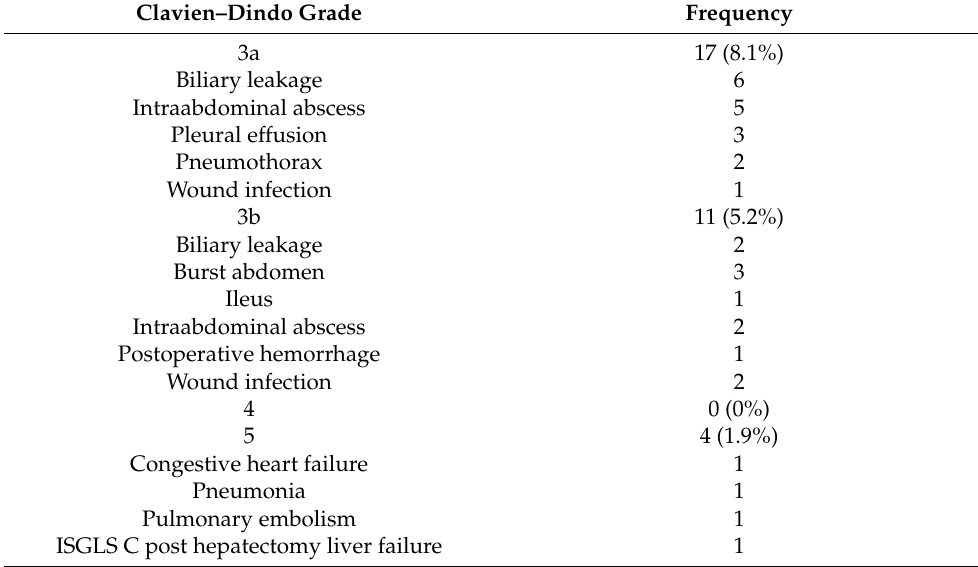
Table 2. Description of major complications.